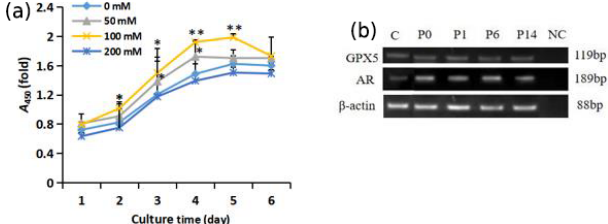
Figure 3. Growth of trehalose-treated sheep EECs. (a) The growth curve of sheep EECs treated with different concentrations of tre- halose. * P < 0 . 05 and ** P < 0 . 01 compared with the 0mM trehalose-treated group. Error bars indicate the standard deviations. (b) RT-PCR analysis of GPX5 and AR in isolated EECs cultured with trehalose at passage (P)0, P1, P6, and P14. C refers to EECs cultured without trehalose at passage P0. NC refers to negative con- trol, and β - actin was used as an internal